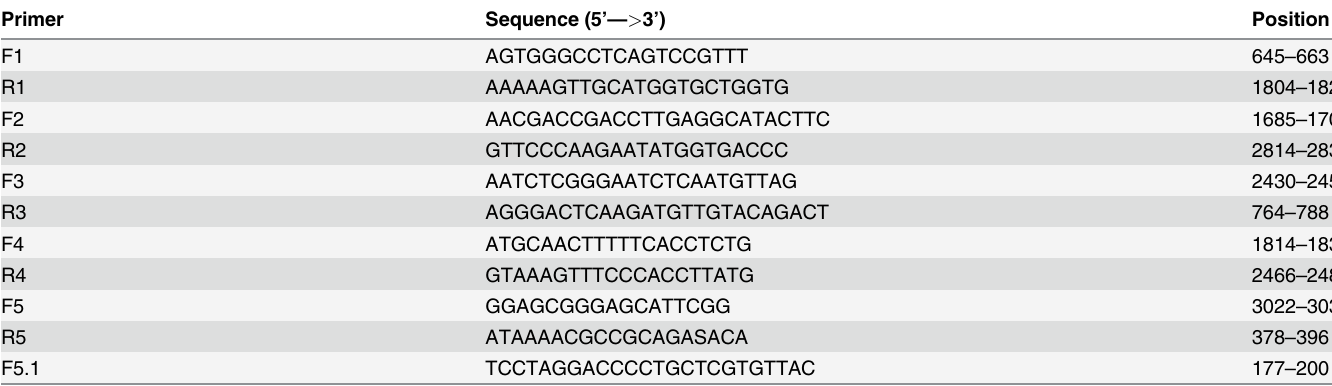
Table 1. Primers used for Illumina sequencing and direct PCR sequencing of